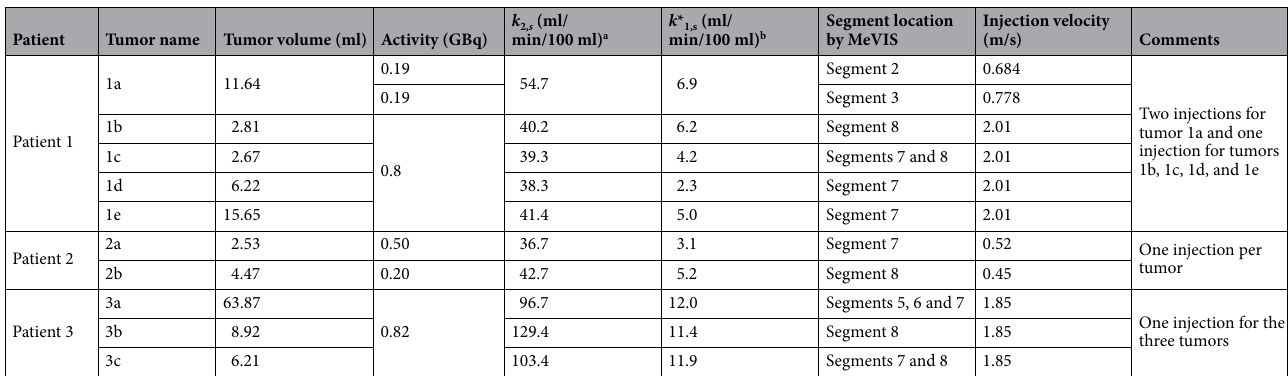
Table 2. Information of the tumors and the RE procedures in each of the three patients. a Tumoral arterial perfusion. b Healthy parenchyma arterial